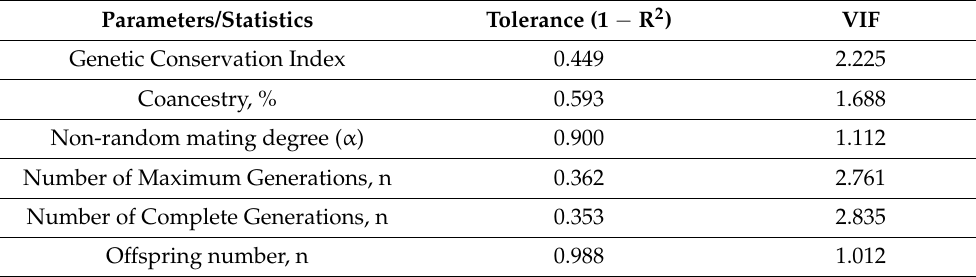
Table 8. Multicollinearity analysis of genetic diversity parameters.